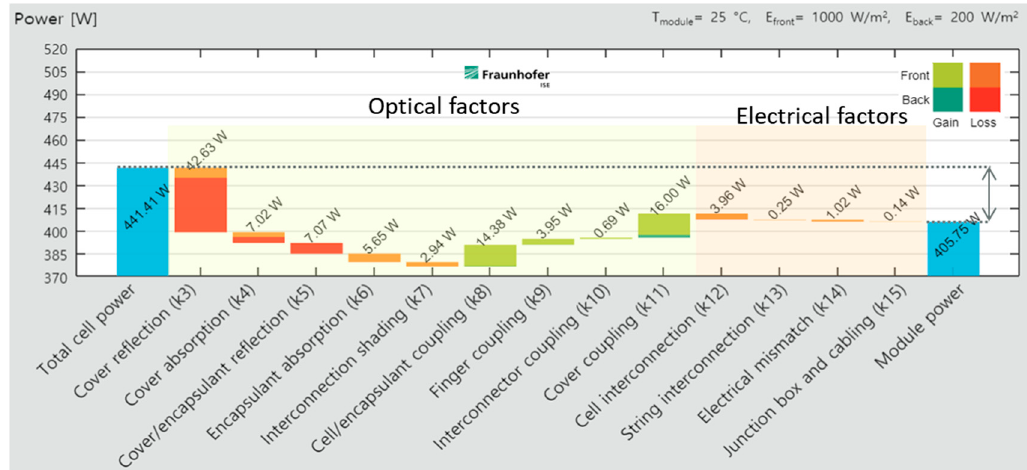
Figure 3. Waterfall diagram showing individual cell-to-module losses and gains, leading to the cell-to-module (CTM) ratio of the module.